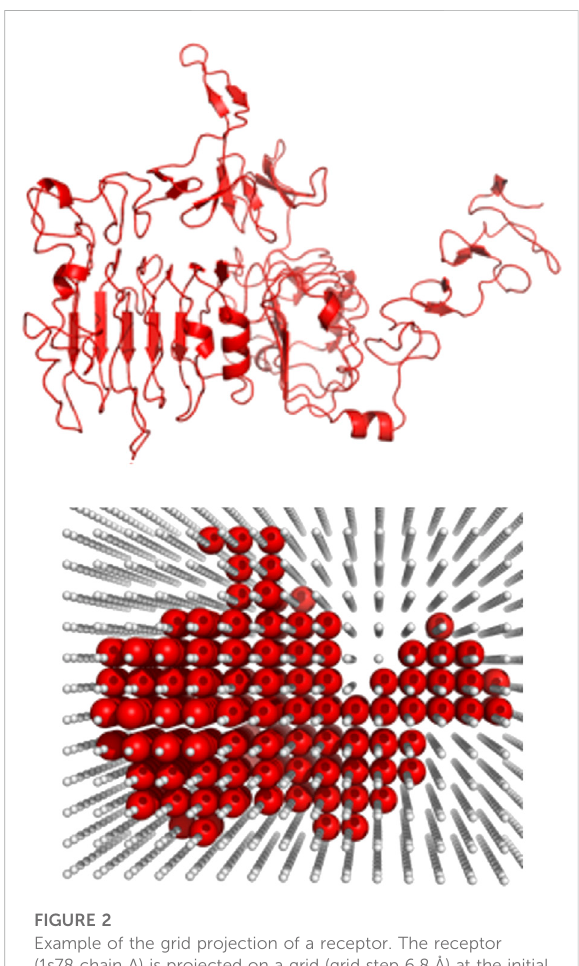
FIGURE 2 Example of the grid projection of a receptor. The receptor (1s78 chain A) is projected on a grid (grid step 6.8 Å) at the initial stage of the packing